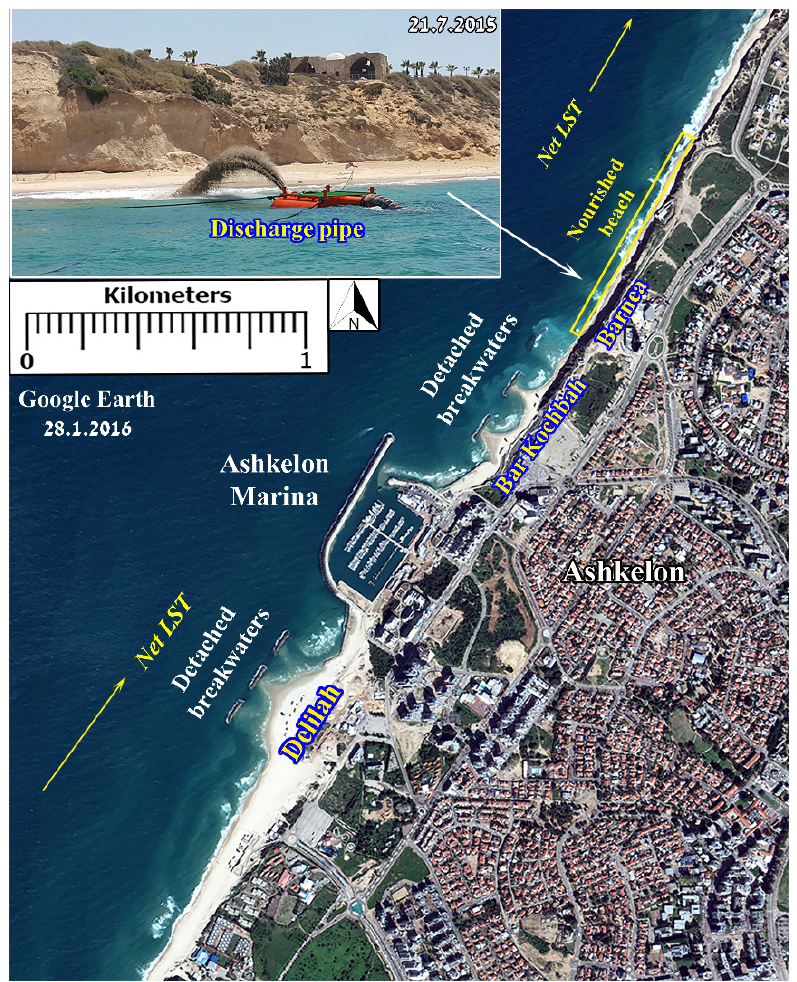
Figure 4. North Ashkelon sand beach nourishment project (July–October 2015). Nourishment rainbowing operation via discharge pipe (top inset). Background: Google Earth image, 28 January 2016.